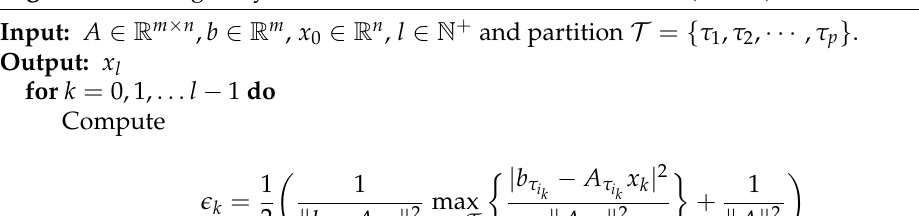
Algorithm 2 The greedy randomized Kaczmarz block method